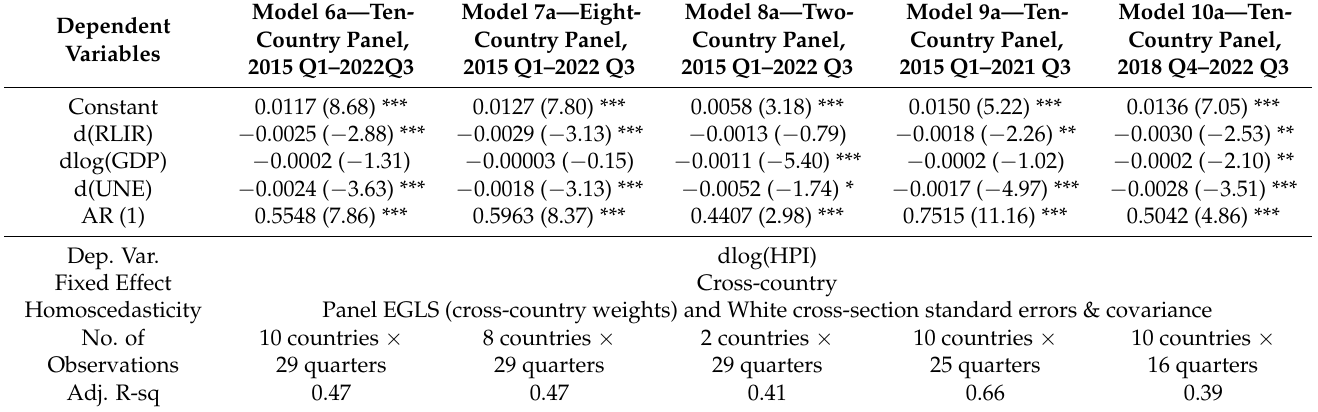
Table 6. Results of the ten-country panel regression models on house price change and real long-term interest rates, with panel EGLS (cross-section weights and White cross-section standard errors and covariance.